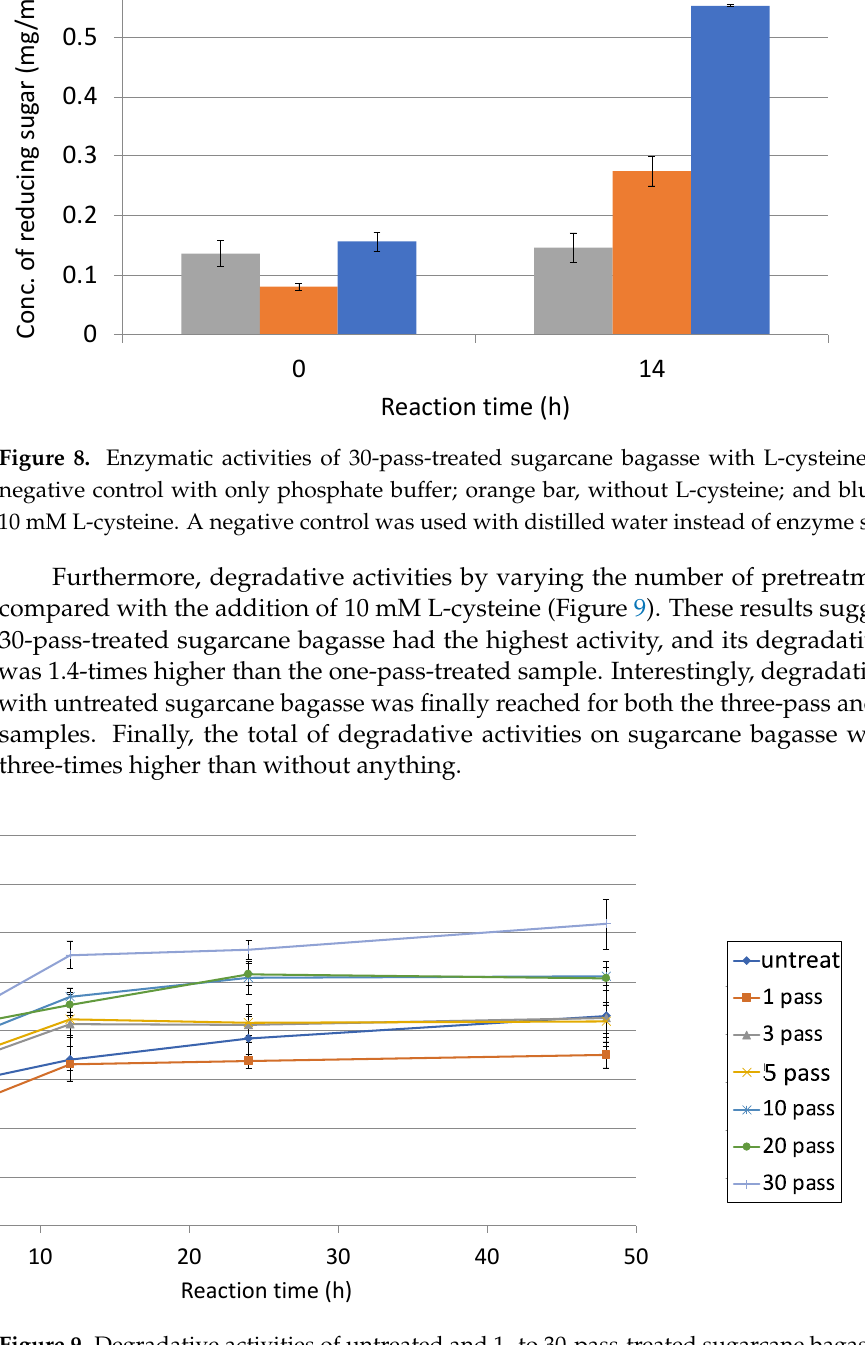
Figure 9. Degradative activities of untreated and 1- to 30-pass-treated sugarcane bagasse using E3 with 10 mM L-cysteine. 2% ( w / v ) sugarcane bagasse was pretreated by the wet jet milling device. After the pretreatment from 1 to 30 passes with the device or without it, all samples were used as a substrate for enzymatic reaction. D-Glucose was used as a standard curve for reducing sugars. Each line indicates each